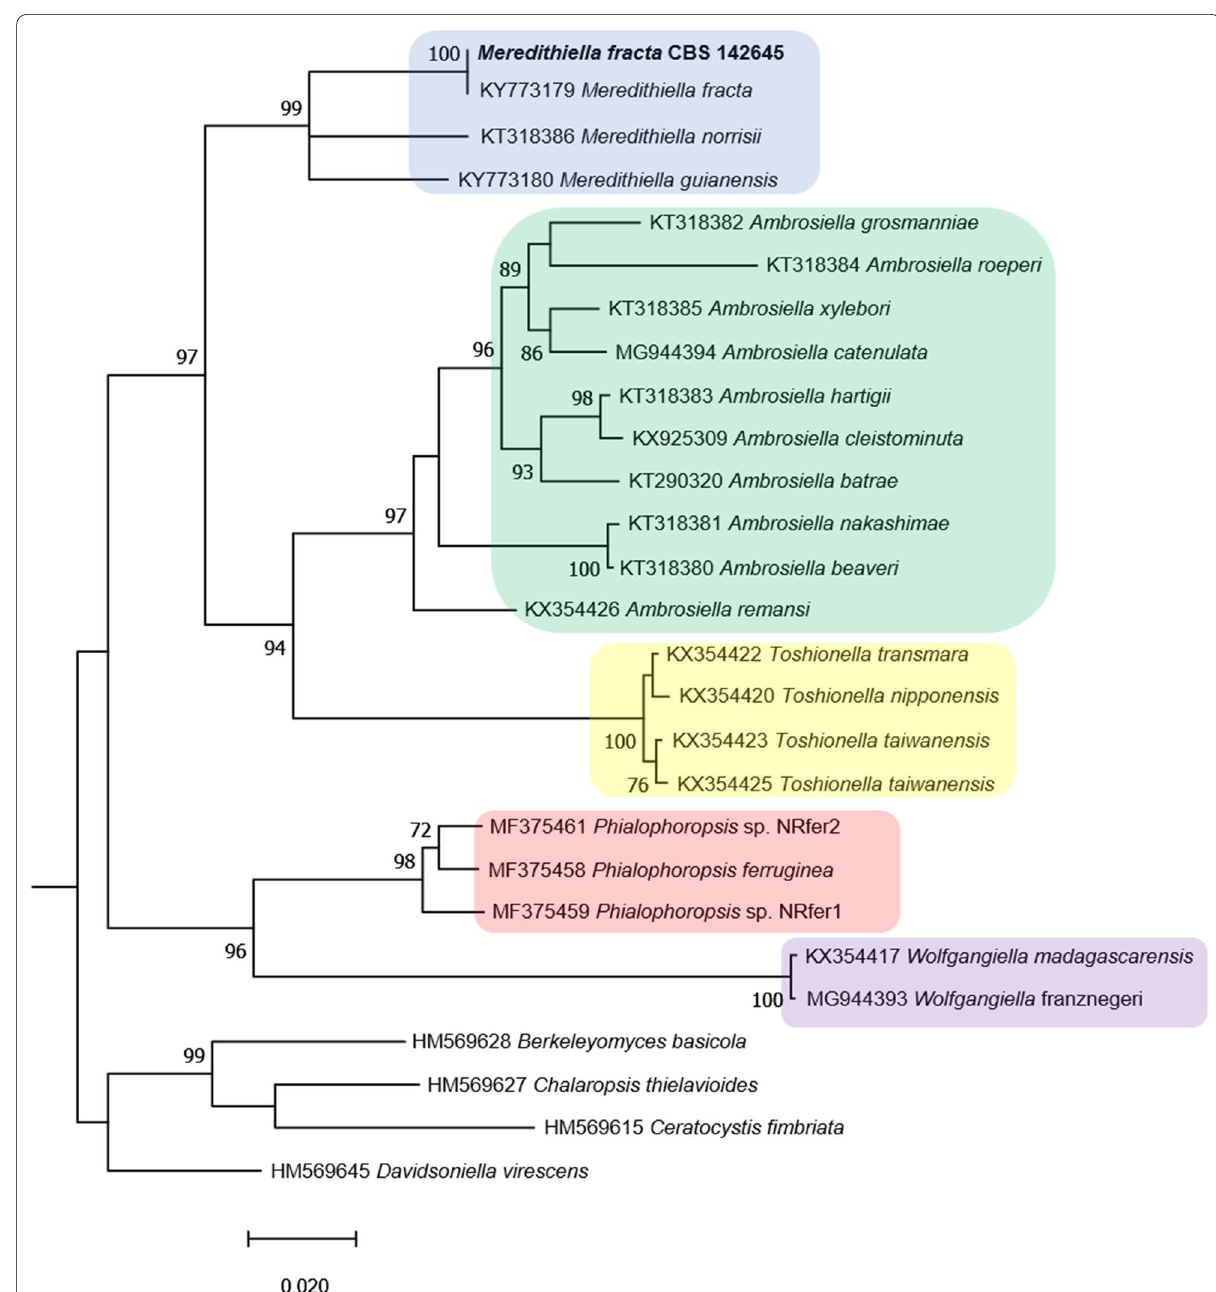
Fig. 2 A maximum‑likelihood phylogeny based on the TEF1 gene from species of Meredithiella (blue), Ambrosiella (green), Toshionella (yellow), Phialophoropsis (red) and Wolfgangiella (purple). This analysis confirms the identity of the genome assembly presented here (shown in bold) as Meredithiella fracta . Berkeleyomyces basicola , Chalaropsis thielavioides , Ceratocystis fimbriata and Davidsoniella virescens were used as outgroups, and the results for the approximate likelihood ratio test for branch support are shown as